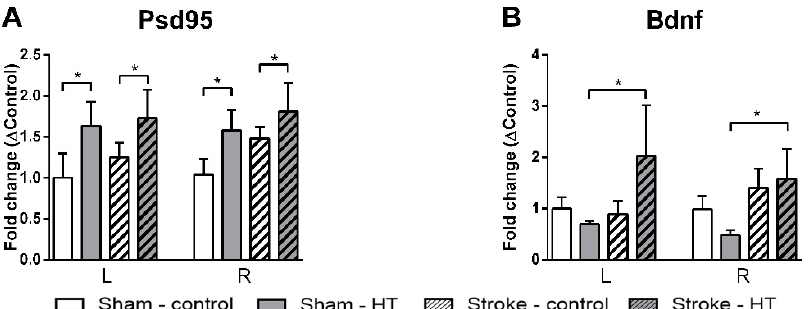
Figure 18. mRNA expression of ( A ) postsynaptic density protein 95 (Psd95), ( B ) brain derived neurotrophic factor (Bdnf) in frontal parts of the brain 35 days after surgery. ( A ) All HT-mice showed an up-regulation in Psd-95 expression without differences between hemispheres ( p < 0.018). ( B ) Bdnf was higher expressed in stroke HT-mice ( p < 0.018) than in sham-HT mice. Values represent mean ± SEM. * p < 0.05.